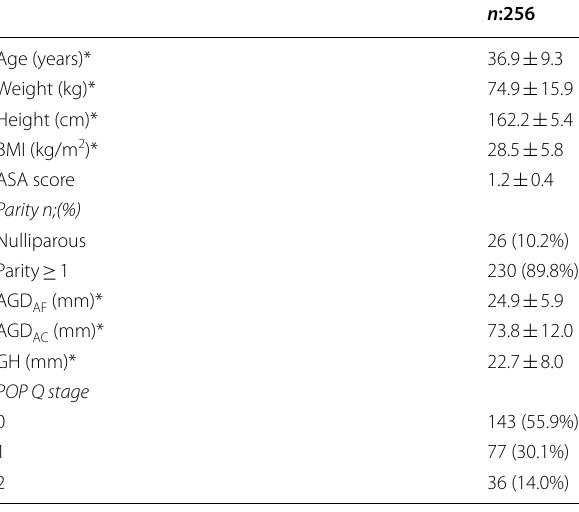
Table 1 Demographics data of all patients